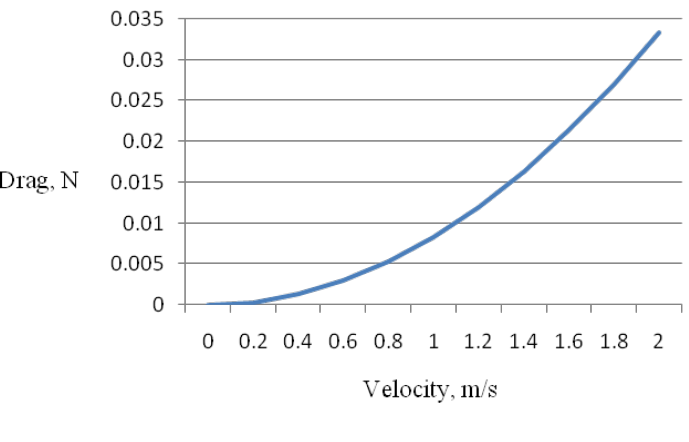
Figure 4. Drag of